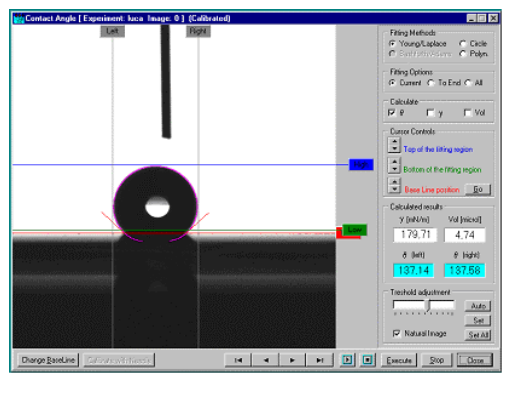
Figure 2. Characterisation of the PSi surface by contact angles measurements. A) The PSi as etched shows a clearly hydrophobic behaviour. B) After the passivation process the PSi surface is hydrophilic thus allowing the penetration of biological solution.